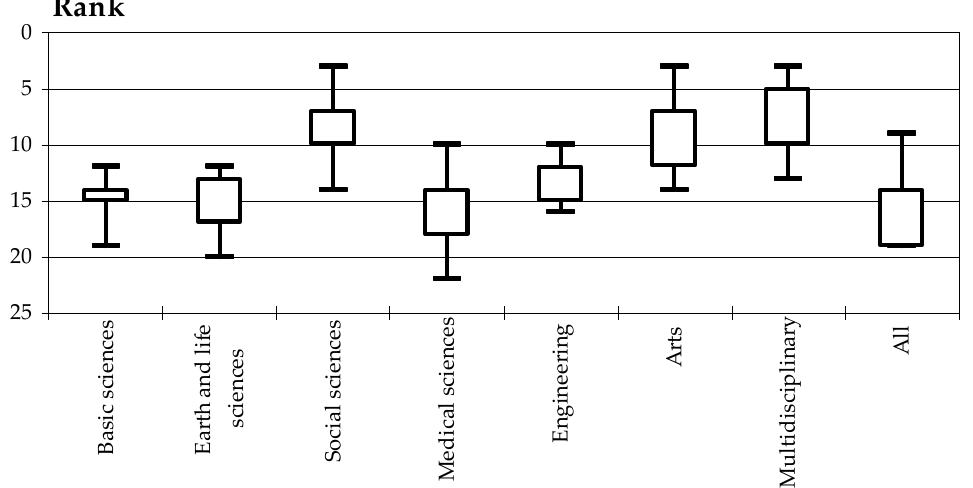
Figure 7. The visibility of articles published in aggregated research areas in Poland during 2010–2018, measured based on the adjusted number of citations per document. The figure displays boxplots based on the ranks of the aggregated research areas computed for each year separately. Results indicate a huge variability and allow for the identification of several patterns.